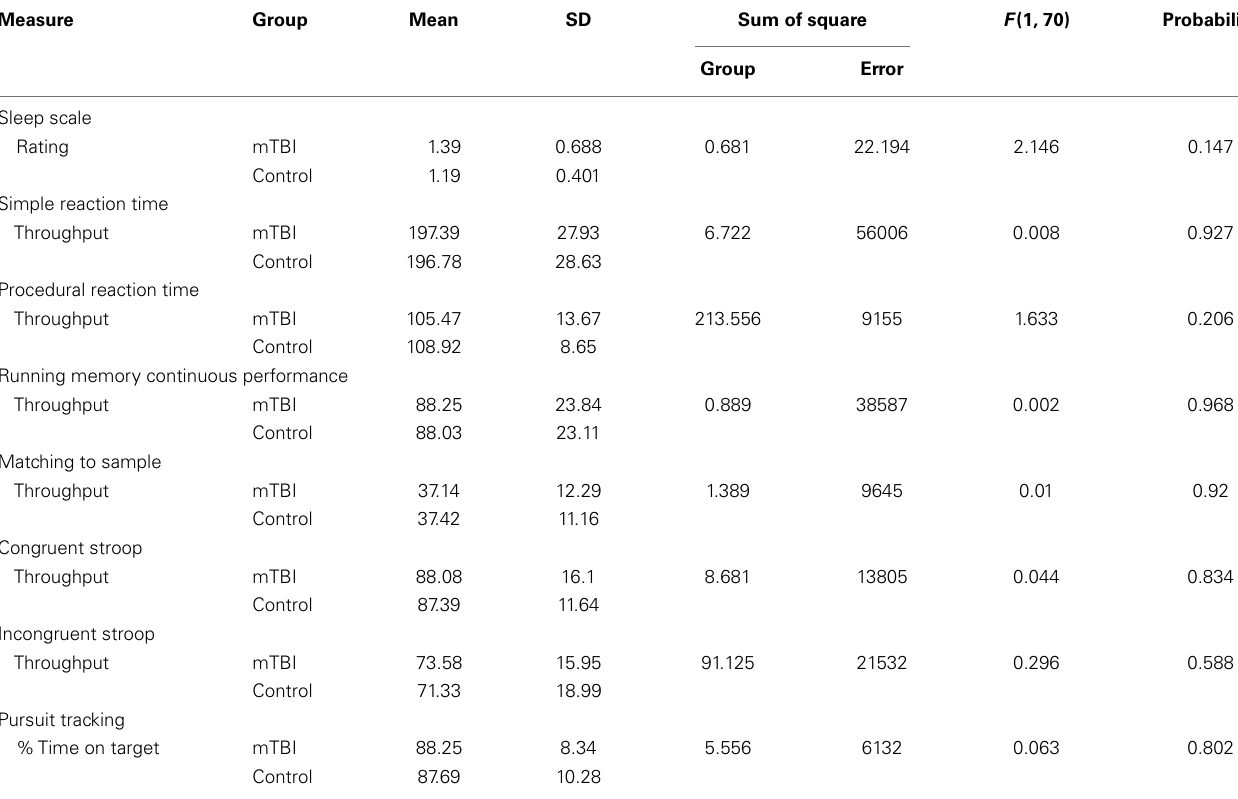
Table 5 | MSL1 means and SDs of the eight BrainCheckers test scores for the mTBI and the control subjects along with the results of theANOVA.